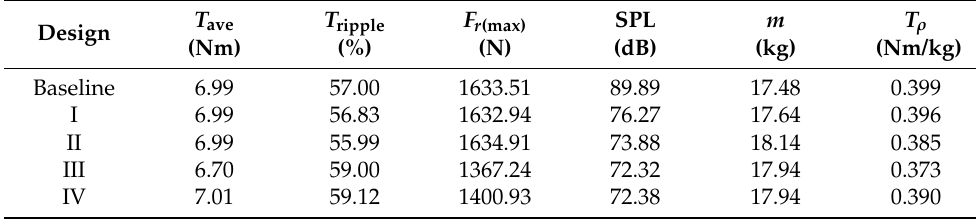
Table 16. Performance comparison of the structural modifications evaluated for the 8/6 SRM.